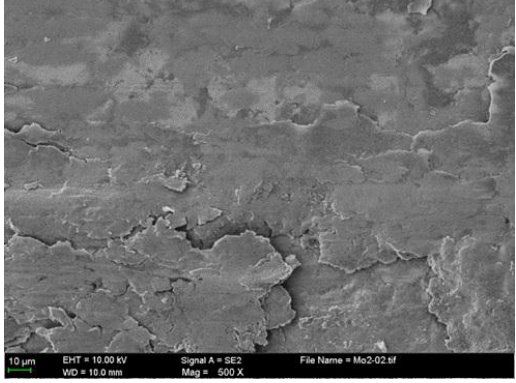
Figure 8. Enlarged worn surface from the NCM ring.